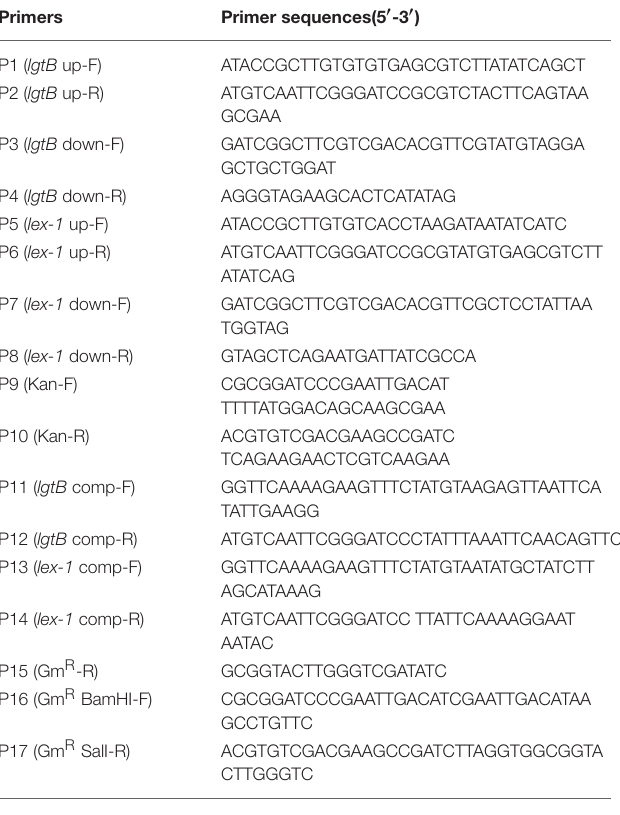
TABLE 2 | Sequences of the PCR primers used in this